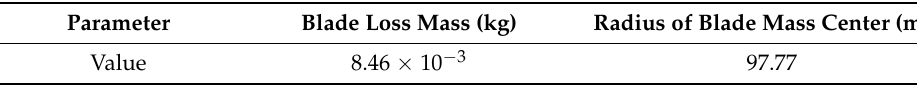
Table 2. Blade released parameters.